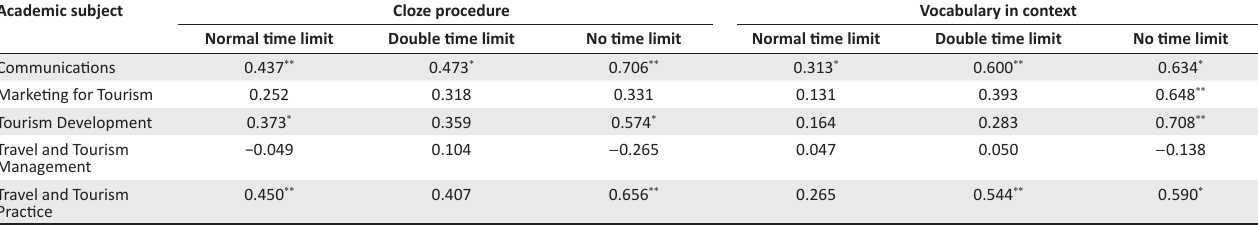
TABLE 2: Pearson’s r correlations between the English Literacy Skills Assessment tests and first-test subject marks by time-limit